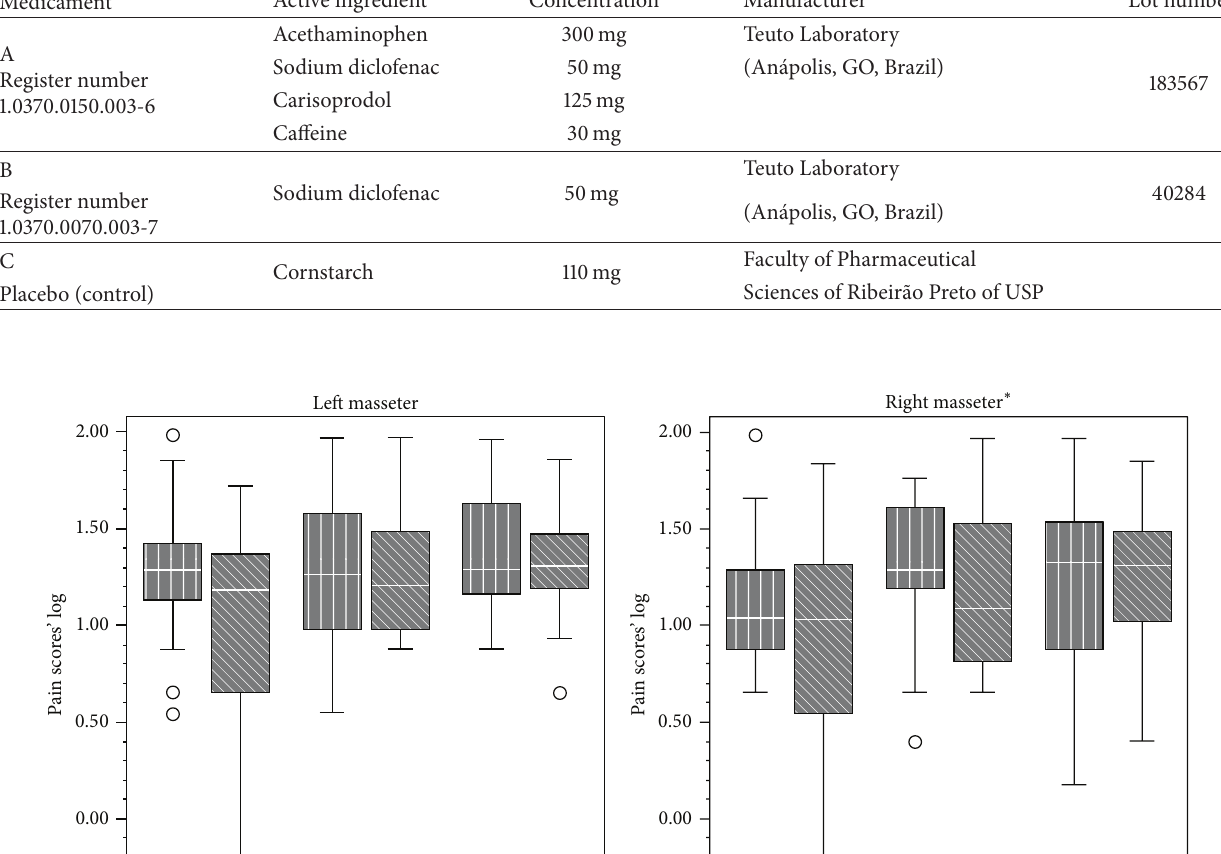
muscle, in which differences were observed between groups A and C ( 𝑃 < 0.05